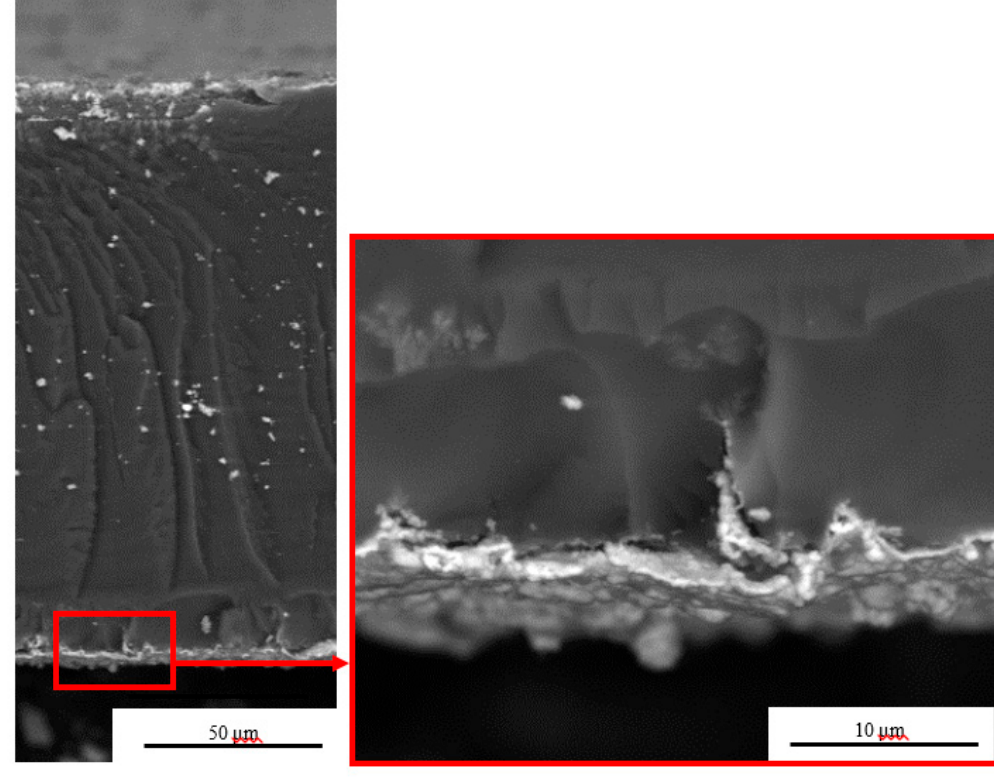
Figure 2. SEM cross-section of the sample (L4).